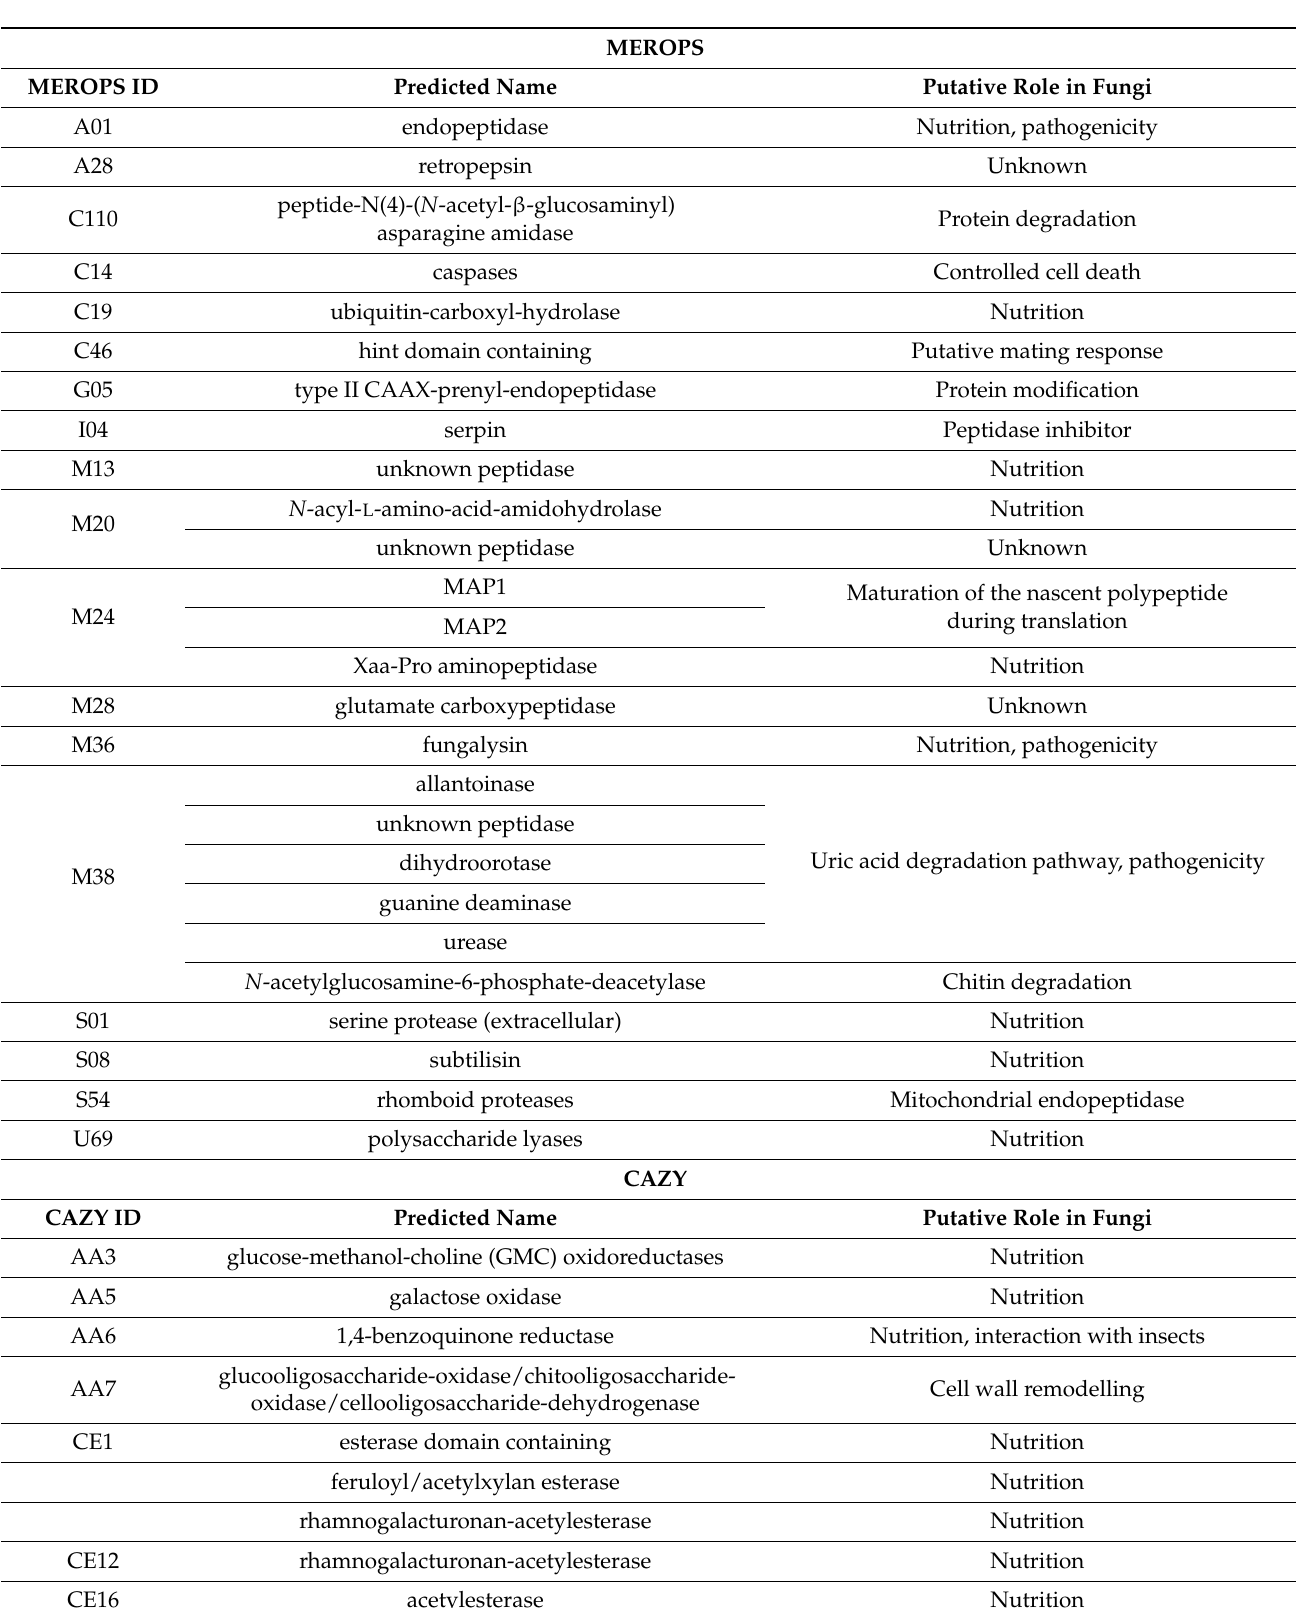
Table 1. Summary of protein families with statistically significant changes in copy number distri- bution among early-diverging fungi (EDF). Functional annotations were based on UniProt, protein domain role and literature